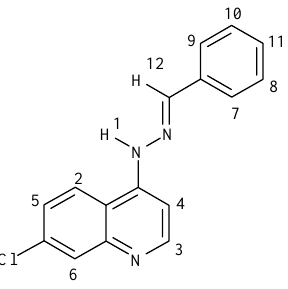
Figure 1. 7-Chloro-4-(benzylidinehydrazo)quinoline ( HL